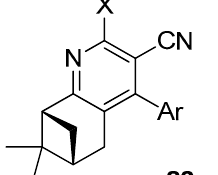
Figure 18. Structural formulas of α -pinene and β -pinene enantiomers.